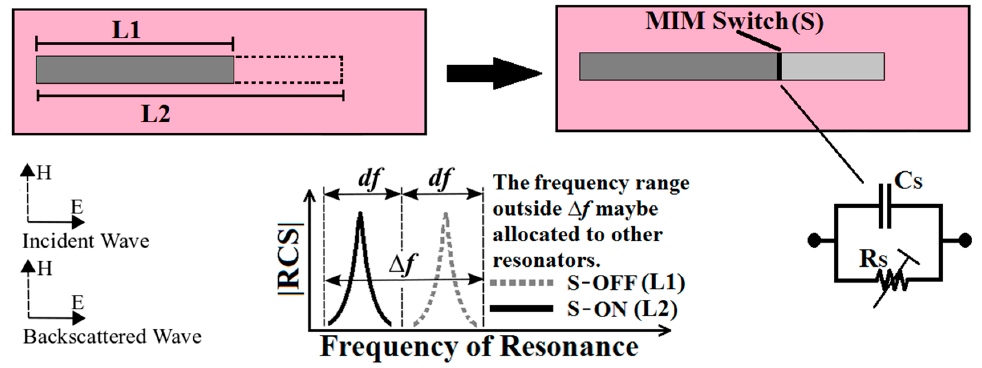
Figure 8. Concept of application of MIM switches in an RF-encoding particles (REP) for chipless radio frequency identification (RFID) tag.